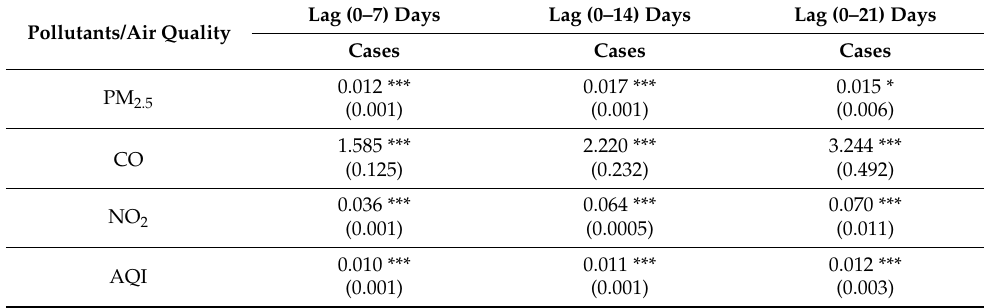
Table A5. Result of the FGLS